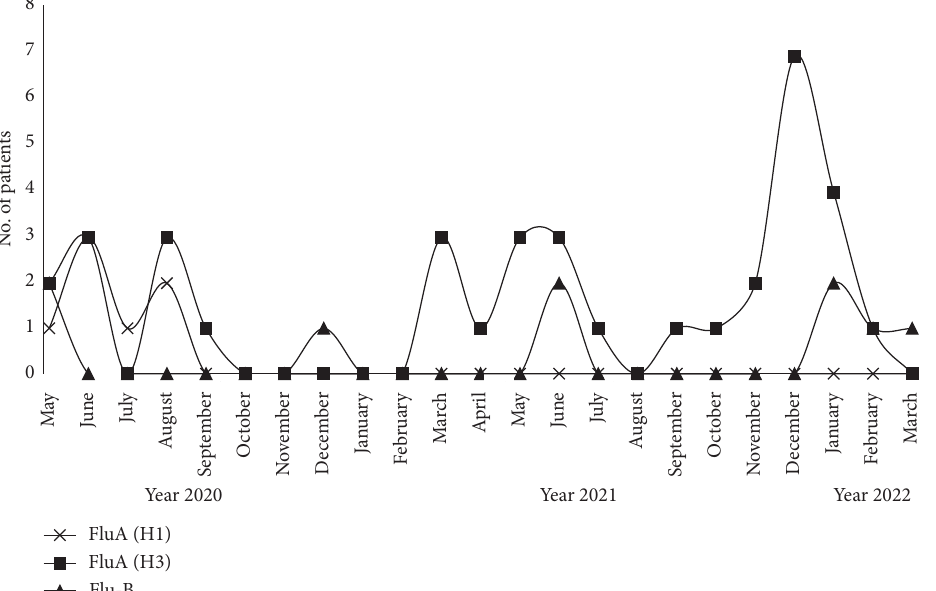
Figure 2: Monthly distribution of SARS-CoV-2 and infuenza co-infection by infuenza subtype, Egypt integrated acute respiratory surveillance,